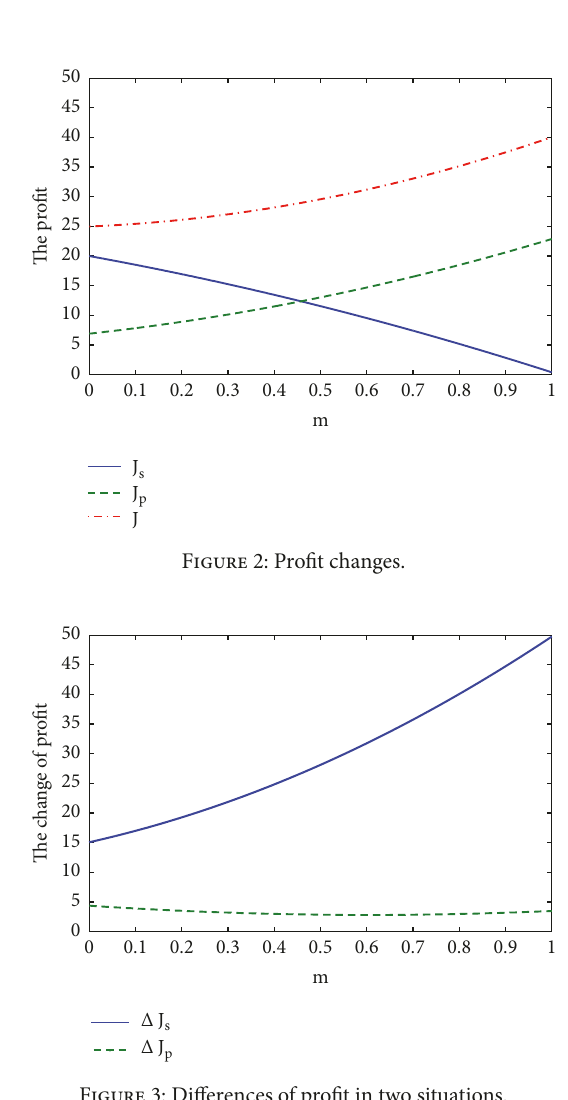
Figure 3: Differences of profit in two